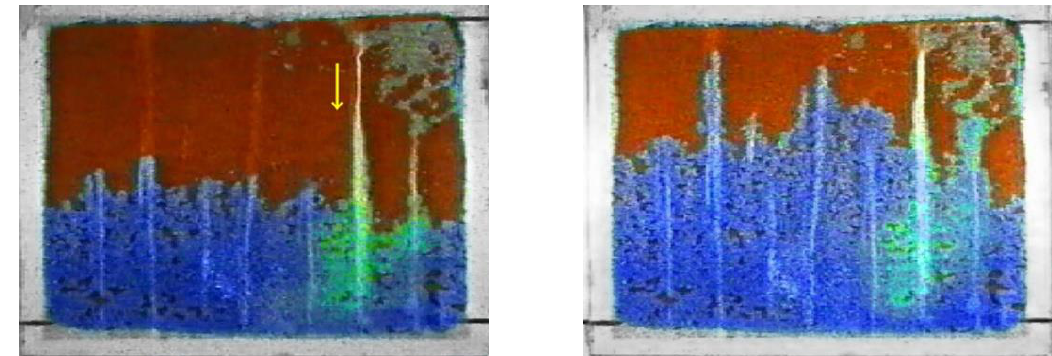
( c ) (the arrow represents injection channel of gelant) Figure 11. Cont